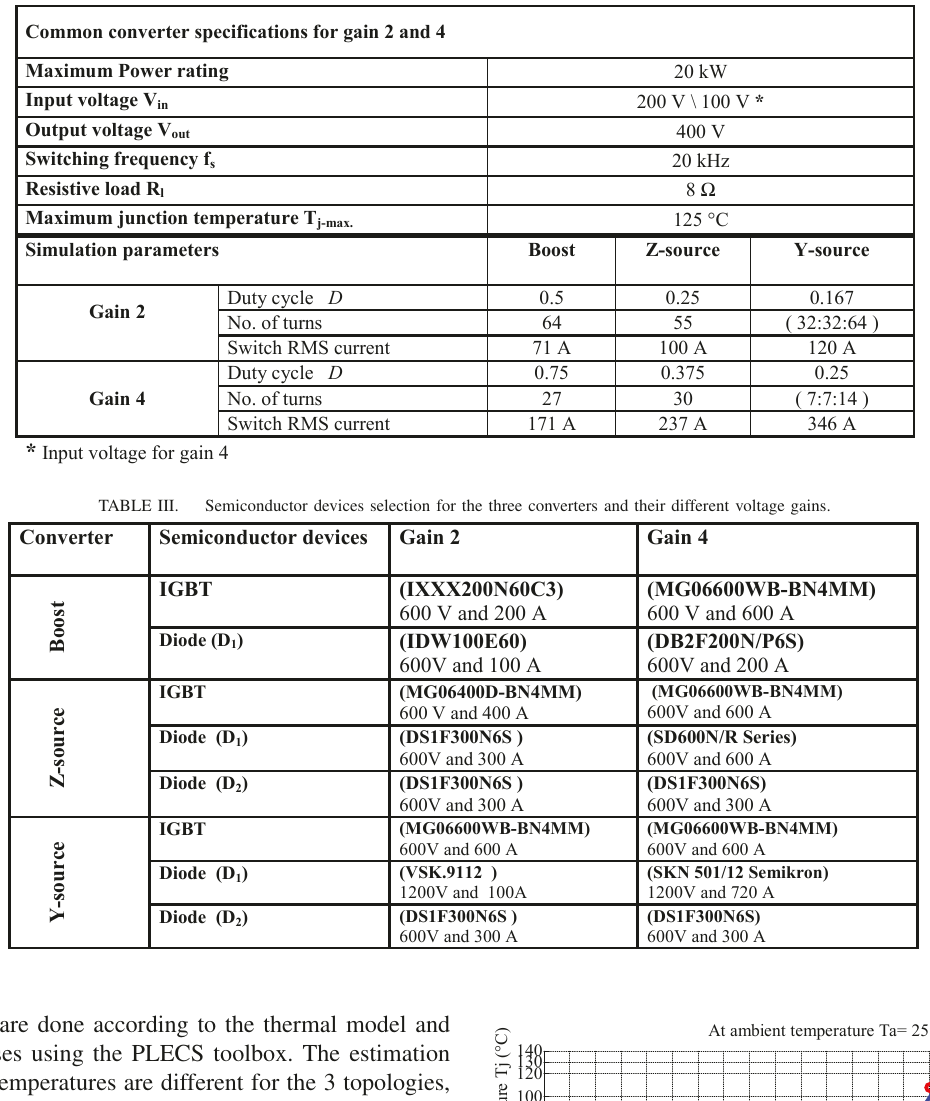
TABLE II. Common specifications and simulation parameters for the Boost, Z-source and Y-source converters